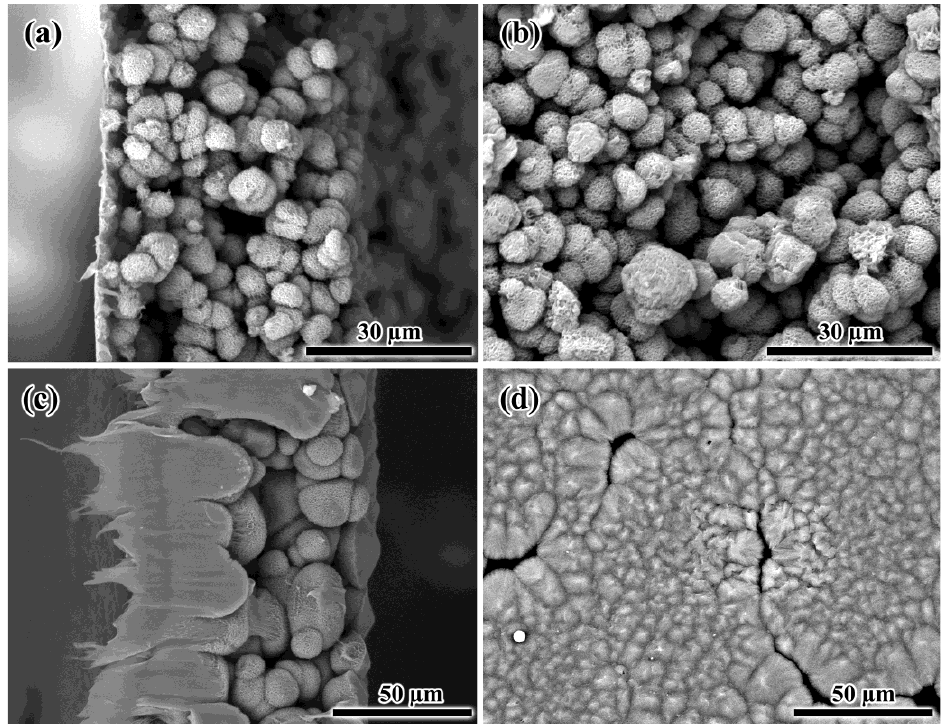
Figure 7. SEM images of the cross-sections ( a , c ) and surfaces ( b , d ) of the porous films obtained from 25% ( a , b ) and 40% ( c , d ) polylaurolactam solutions by cooling.